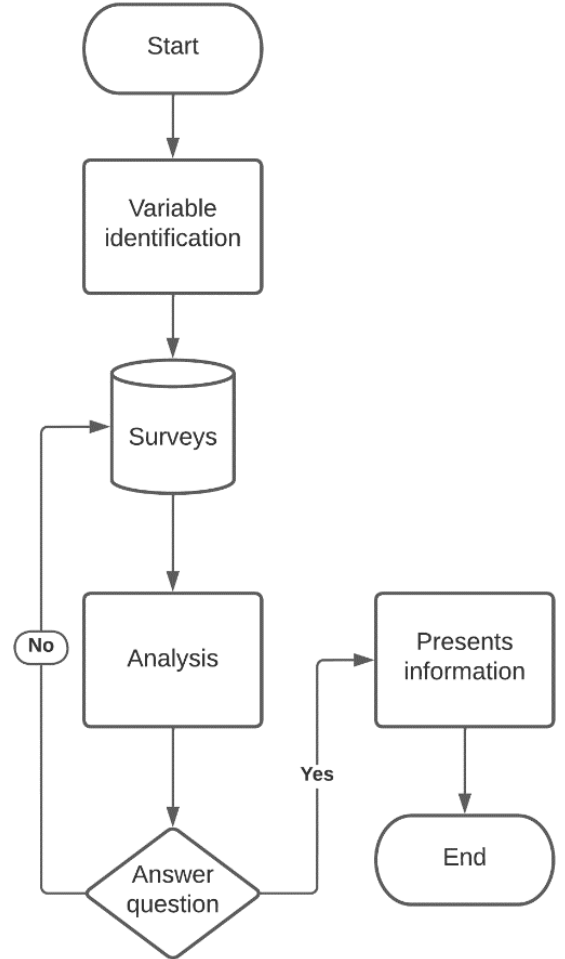
Figure 2. Flowchart of methodology for the analysis of the indicators that affect the use of eCom-merce.